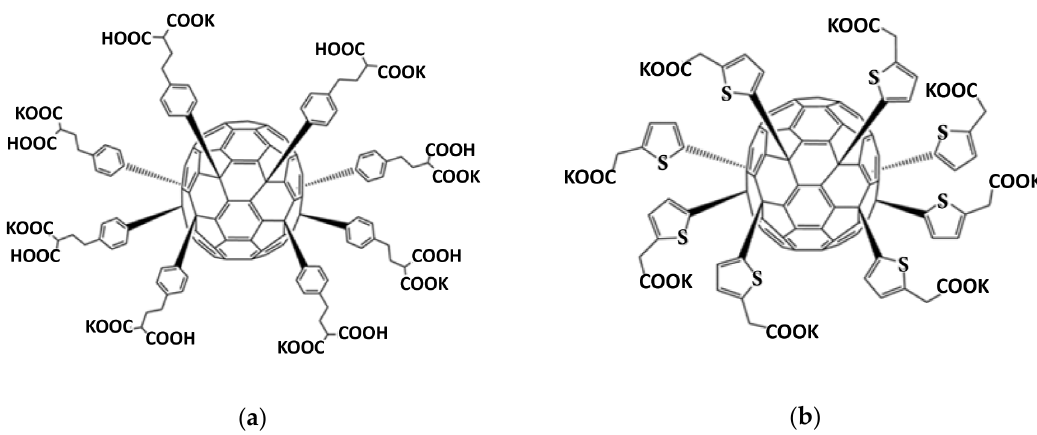
Figure 1. Molecular structures of ( a ) ethylphenylmalonate C 70 derivative (FF1) and ( b ) thienylacetate C 70 derivative (FF2) functionalized fullerenes (FF).